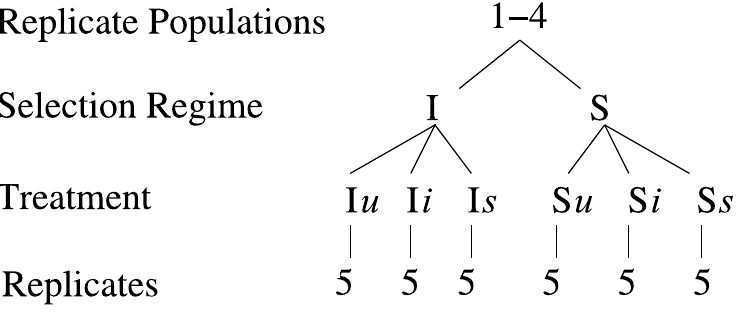
Fig 1. Experimental design for the NMR metabolomics experiments. Four independentblocks, each havingtwo regimesI and S were subjectedto three treatments. Each treatment had 5 replicates.